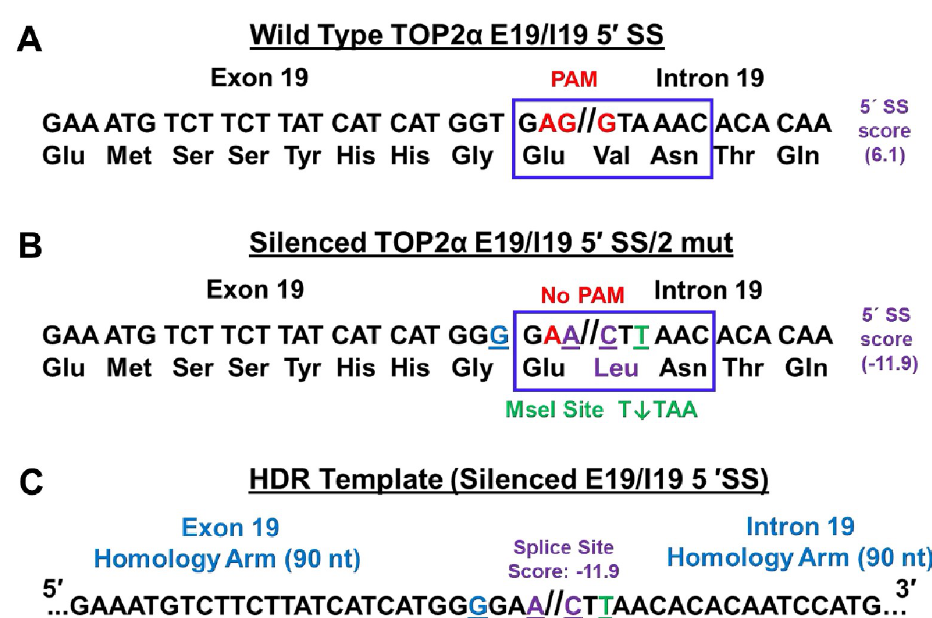
Fig 1. Strategy to utilize CRISPR/Cas9/HDR to silence the TOP2 α E19/I19 5 0 SS in K562 cells. (A) The TOP2 α E19/I19 gene boundary sequence is shown. The wild-type E19/I19 5 0 SS sequence to be edited by CRISPR/Cas9 is boxed in blue. The SS splicing score is also denoted. The PAM site is denoted in red. (B) The proposed two sequence changes to “silence” the E19/I19 5 0 SS (boxed in blue) are underlined and denoted in purple (G//G ! A//C). The G ! A edit is synonymous and would not result in an amino acid change in the TOP2 α /170 protein. The G ! C edit is nonsynonymous and would result in an amino acid change (Val ! Leu, shown in purple) in the TOP2 α /90 isoform if expressed. The “silenced” 5 0 SS splicing score is also denoted. The proposed sequence changes to “silence” the E19/I19 5 0 SS also eliminates the PAM site (AGG ! AAC). Additional editing of the last nucleotide of the triplet codon for Leu (CTA ! CTT denoted in green and underlined) introduces a restriction site for the MseI endonuclease (T # TAA). Successful TOP2 α gene editing would allow for MseI digestion at the E19/I19 boundary. The triplet GGT codon upstream from 5 0 SS was also edited to a GGG, a synonymous change denoted in blue, to allow for greater discrimination between the wild-type and edited E19/I19 boundary using a specific qPCR probe. (C) To introduce the proposed changes (underlined and denoted in color) in the TOP2 α E19/I19 5 0 SS, a ssODN HDR template (denoted “silenced E19/I19 5 0 SS”) was